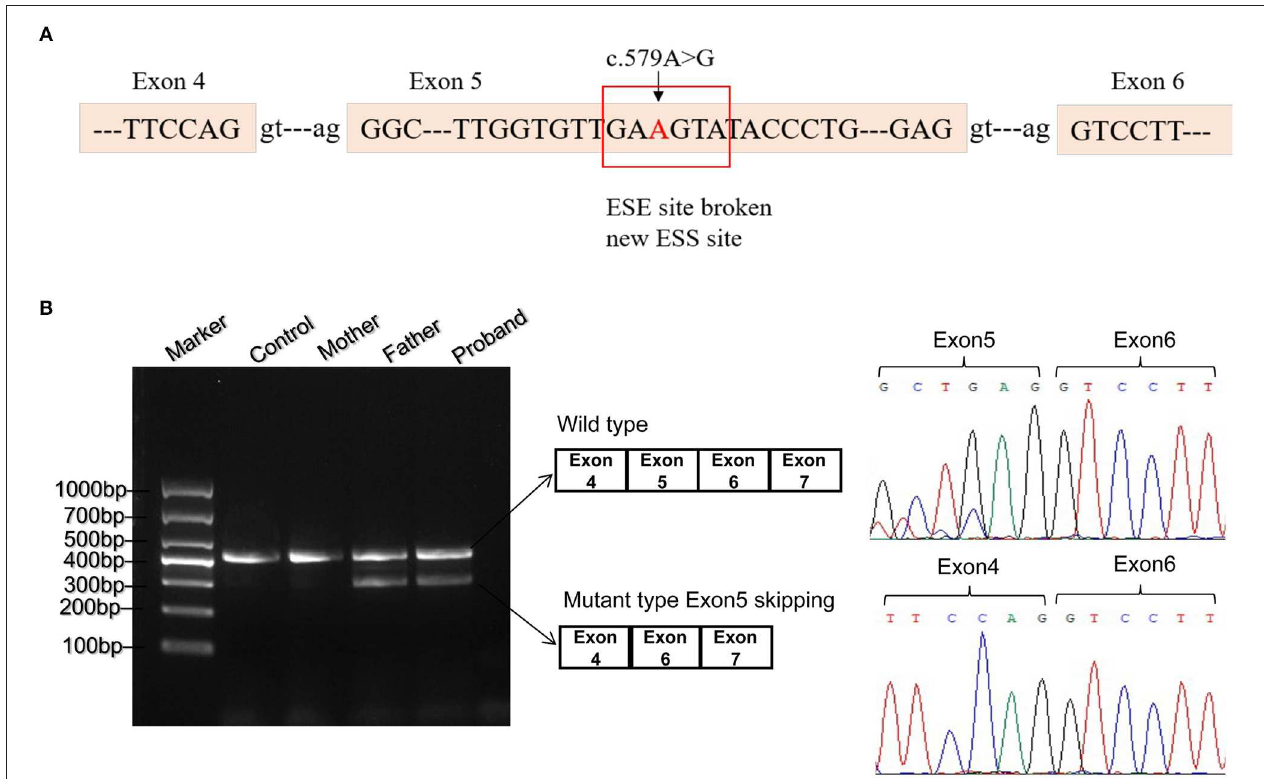
FIGURE 2 | Bioinformatics predictions and transcript analysis in vivo for the synonymous variant c.579A > G. (A) Human Splicing Finder program predicted that c.579A > G might affect auxiliary cis-acting splicing regulatory elements including destroying the original exonic splicing enhancer (ESE) and generating a new exonic splicing silencer (ESS). (B) Gel electrophoresis of RT-PCR fragments in vivo showed that c.579A > G caused abnormal mRNA splicing leading to two transcripts differed by about 100 bp. Sequence analysis of the cDNA showed that the shorter transcript lacked a sequence corresponding to exon 5 of the ETFDH